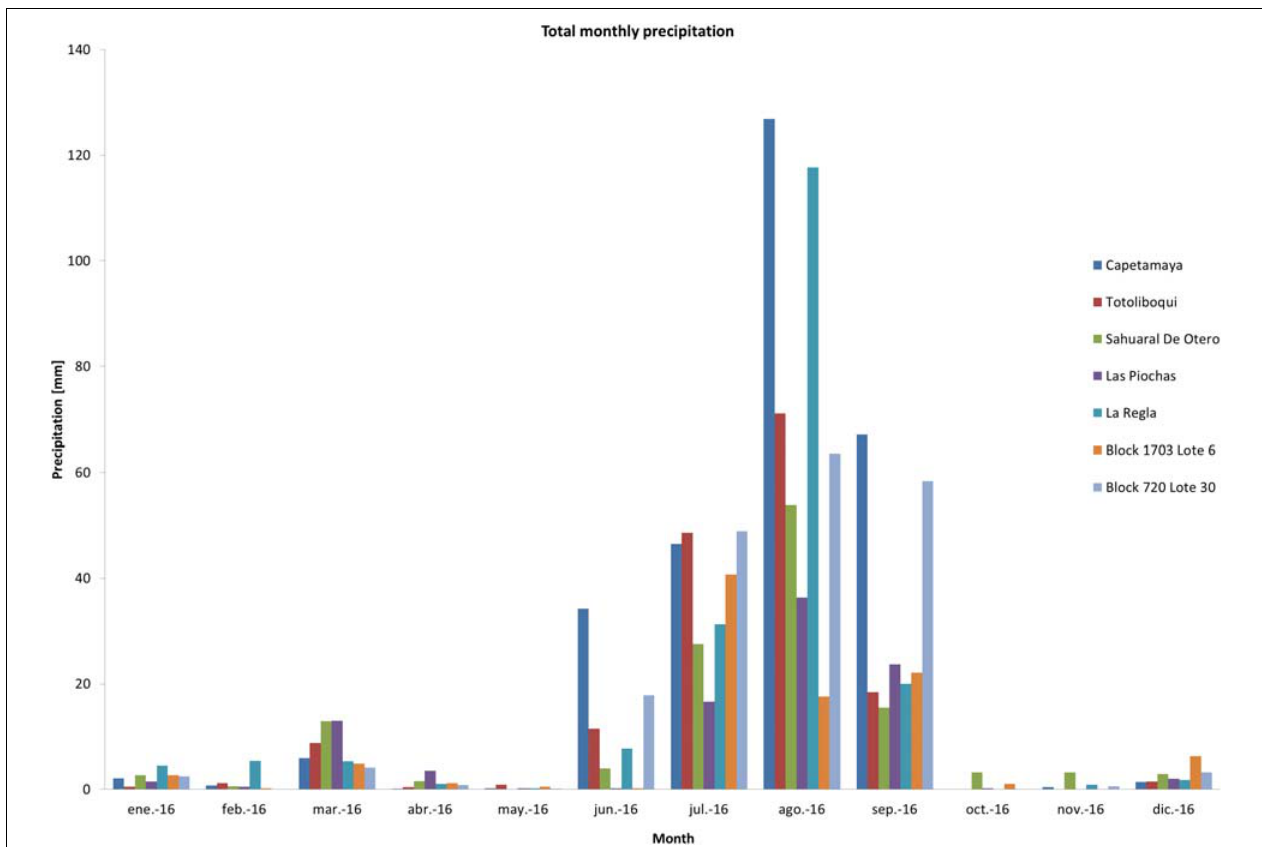
FIGURE 4 | Total monthly precipitation in millimeters measured at weather stations for the Río Mayo Irrigation District during the 2016 period. Of these seven weather stations, four are in the studied zone: Sahuaral De Otero in the North Costa basin and near the aquaculture farms basin, Las Piochasand Capetamaya in the Río Mayo basin, and La Regla in the Yavaros Laguna Yavaros